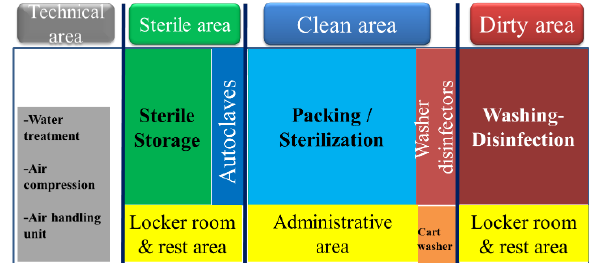
Figure 5 . CSSD-UH of Oujda city: architecture and functional processes